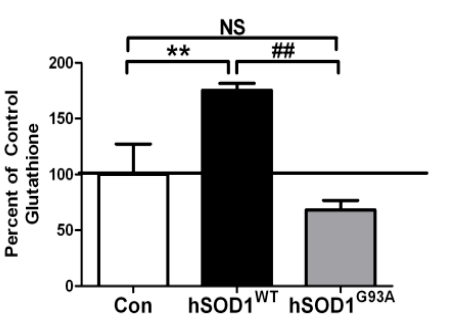
Figure 2. Mitochondrial GSH loading is enhanced with WT SOD1 but diminished with G93A mutant SOD1 in isolated rat brain mitochondria. Isolated rat brain mitochondria were incubated with 2 mM GSH in the presence of vehicle (Con), 25 ng hSOD1WT, or 25 ng hSOD1G93A for 4 h. Samples were washed and total glutathione was measured using a DTNB assay. Mean ± SEM; NS = not significant, ** p < 0.01 versus Con, ## p < 0.01 versus hSOD1WT via a One ‐ way ANOVA with a post hoc Tukey’s test ( n = 3 independent experiments).